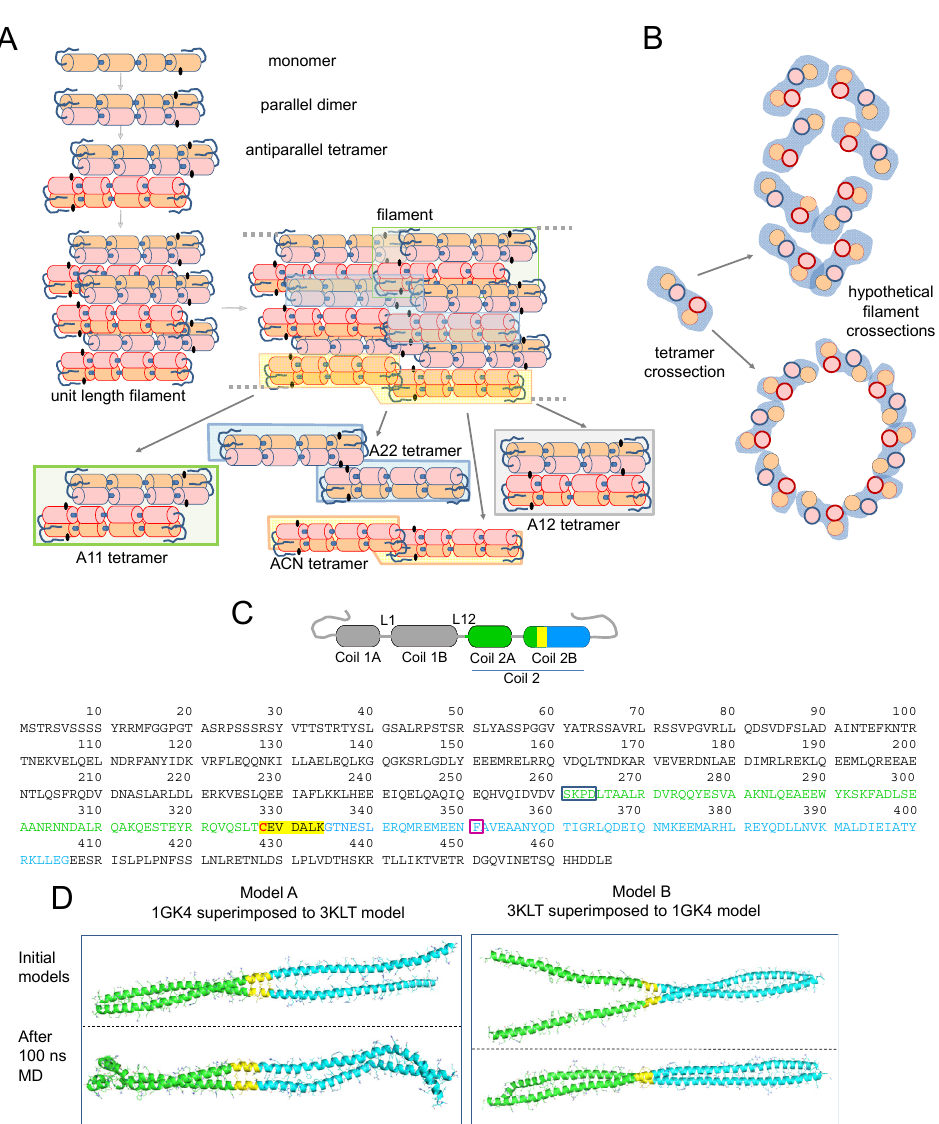
Figure 1. ( A ) Scheme of vimentin assembly and the proposed configurations of vimentin tetramers in filaments (please see text for details). A cartoon view interpretation of the assembly of two unit length filaments (ULF) is presented (labeled as “filament”) showing the potentially key position of the cysteine residue (black dots), which could fall close to the region involved in the connection of two ULFs. Within assembled filaments, vimentin dimers can coincide in different relative positions, thus resulting in several tetrameric configurations, some of which are outlined in the figure by color shadowing and extracted below for easier visualization. ( B ) Cartoon of a tetramer transversal view and hypothetical dispositions of tetramers in a transversal section of a filament. Please note that these schemes are inspired in previous works [17,32] and are not based on molecular dynamics simulations. ( C ) Scheme of a vimentin monomer showing the distribution in coiled coil segments and linkers according to [22]. The segments used for building the models shown in ( D ) are highlighted by a color code: amino acids present in the 3KLT and 1GK4 crystal structures are represented in green and blue, respectively; the region shared between both crystal structures is highlighted in yellow; and the cysteine residue is shown in red. The position of those segments in the full vimentin sequence is depicted underneath by the same color code. In addition, color boxes outline the amino acids integrating the linker (blue) and the position of the stutter (purple). ( D ) Representation of model A and model B, built from the superimposition of 3KLT (green) and 1GK4 (blue) crystal structures on the shared region of both crystal structures (yellow). The upper pictures represent the initial model and lower pictures the model after 100 ns of MD